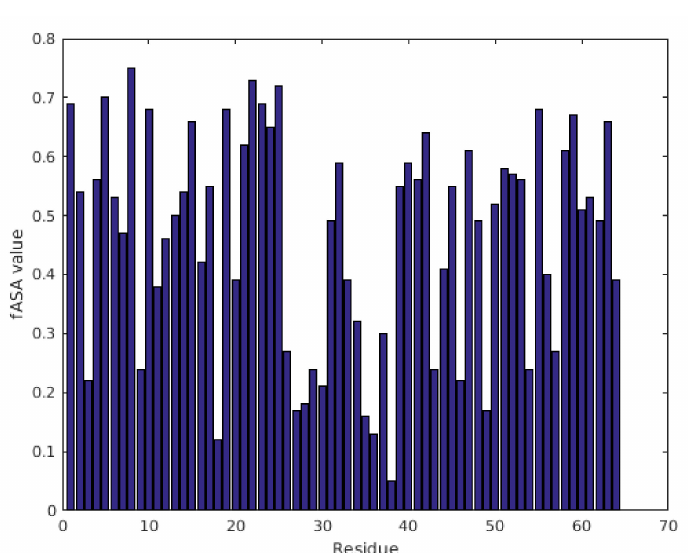
Figure 3. fASA values of PAFC calculated from 13 C chemical shift data show residue-by-residue hydrophobicity of the structure. Residues with fASA values below 0.25 are considered strongly buried, while fASA values above 0.75 indicate exposure to